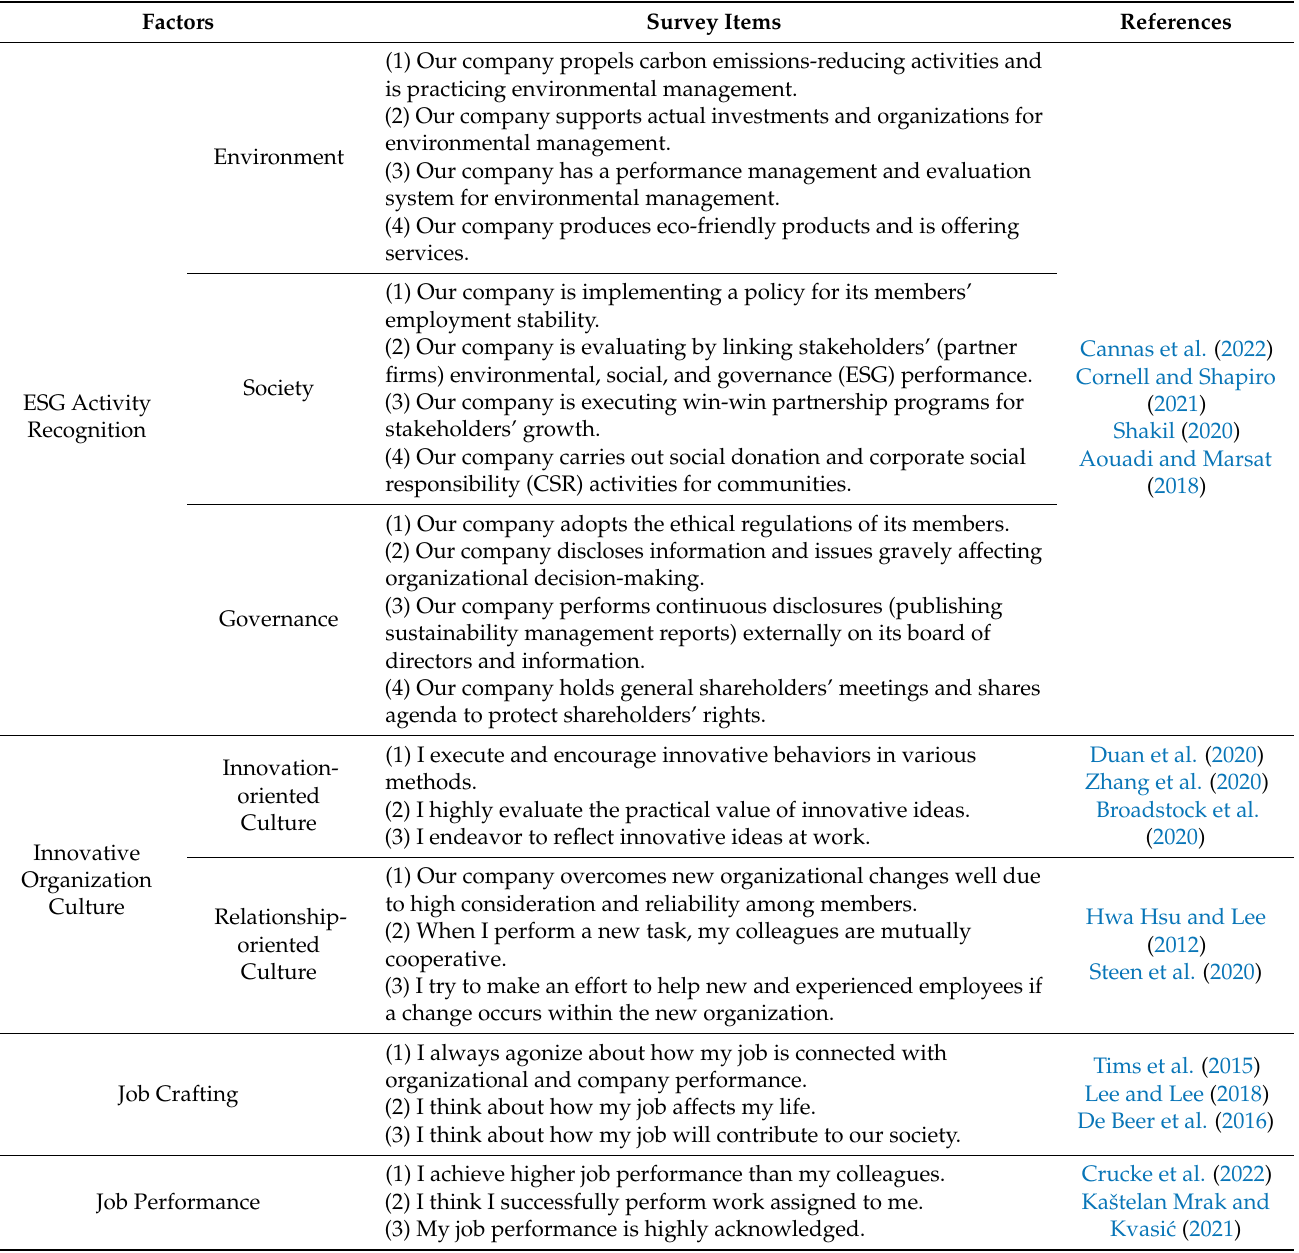
Table 1. Variable definitions and measurement